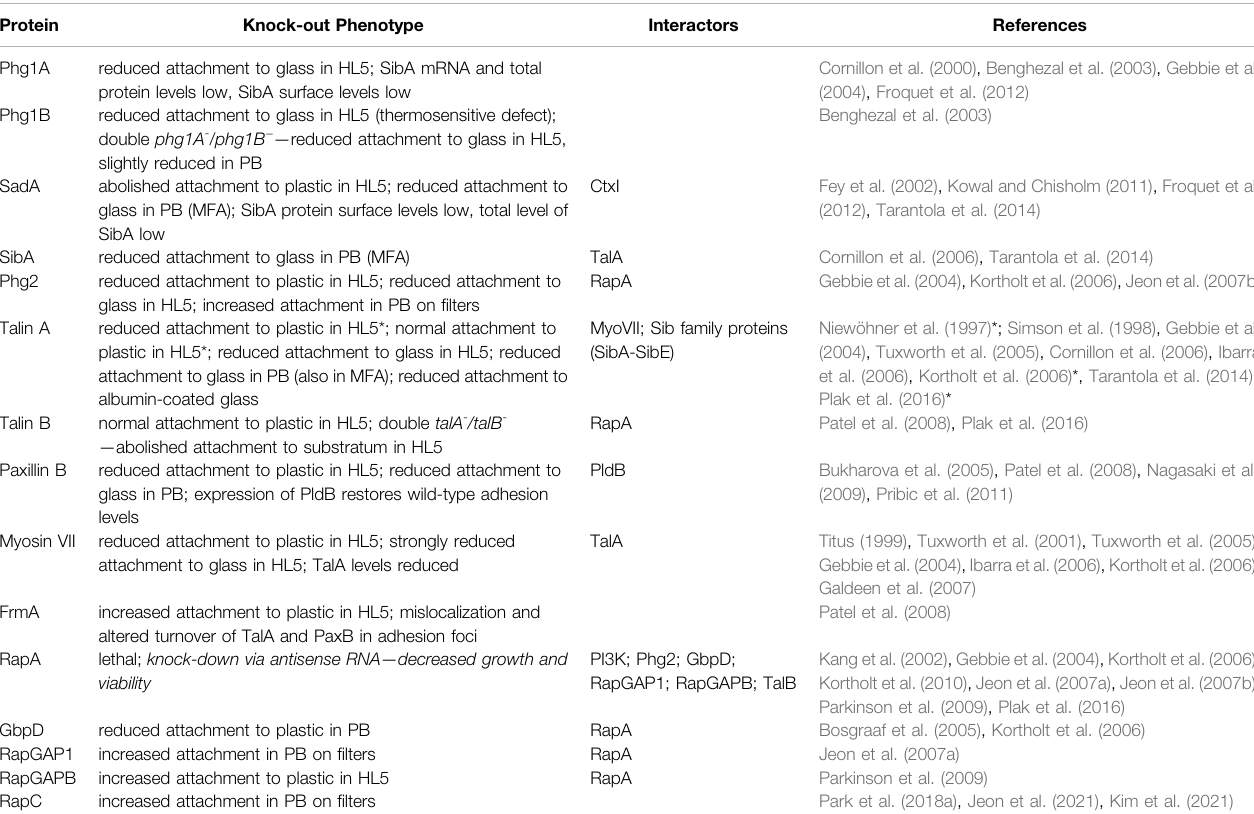
TABLE 2 | Knock-out phenotypes and relevant interactors of core proteins involved in the regulation of the cell-substratum adhesion in Dictyostelium . The list does not includeanumberofproteinsthatwerefoundtoin fl uencetheadhesionbutwerenotcharacterizedindetail.Thephenotypeofknock-outstrainswasdescribedonlyinthe context of the cell-substratum adhesion. The interactions were mostly identi fi ed using pull-down and co-immunoprecipitation assays. Additionaly, some binding partners were detected by GDI (guanine nucleotide dissociation inhibitor) and GAP (GTPase-activating protein) assays, RapA activation assay and yeast-two-hybrid